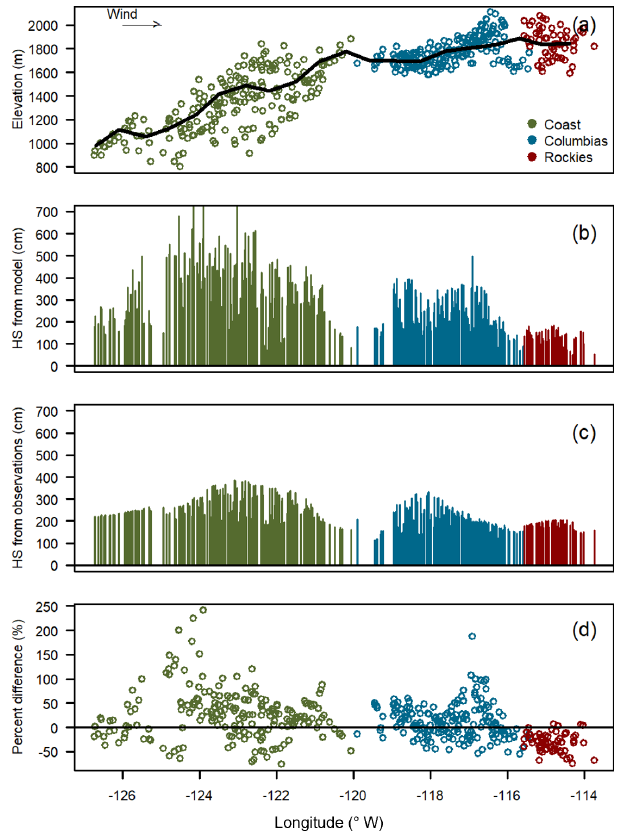
Figure 5. Latitudinal cross section between 49 and 51 ◦ N of (a) the elevation of treeline grid points with the black line showing the moving average, (b) modelled snow depth at treeline grid points, (c) snow depths from upscaled observations at the same grid points, and (d) percent difference between model and upscaled observation snow depths.